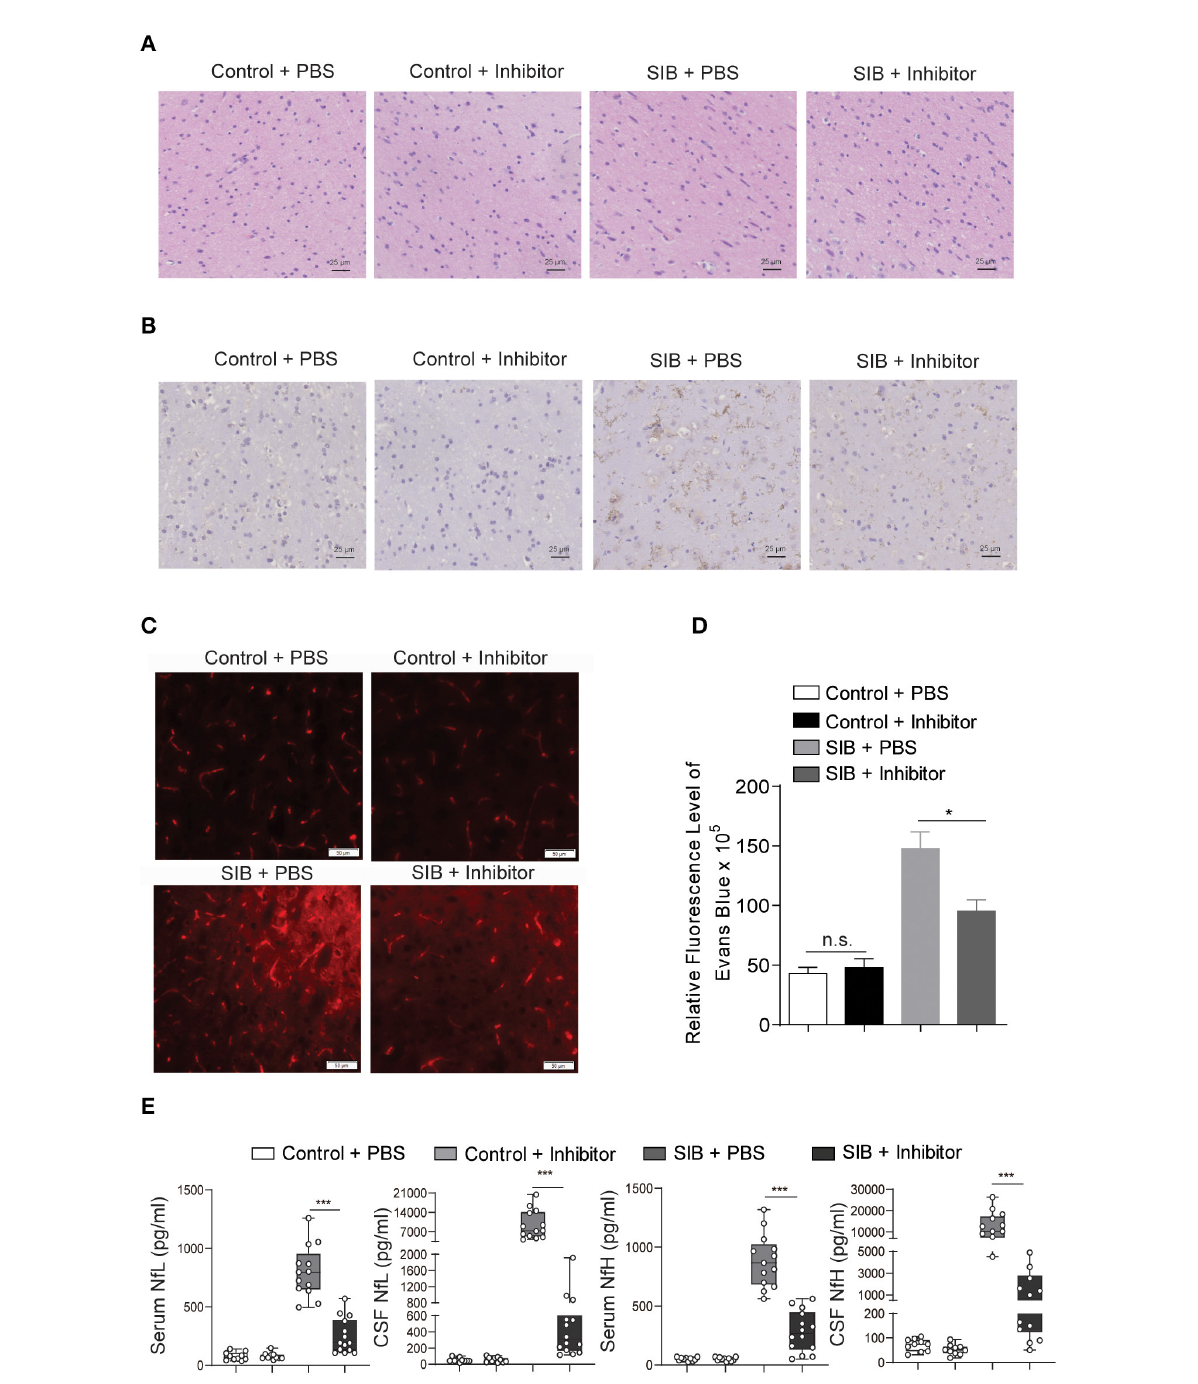
FIGURE5 CBP inhibitor markedly relieves the nerve damage in brain tissues. (A) The hyperplasia of microglial cells was relieved by inhibitor. Representative HE staining in the brain tissues. Scale bars, 25 µ m. Three micrographs per individual were performed for the photomicrographs. (B) Activated Iba-1 microglial cells were decreased in SIB + CBP30 group. Representative IHC stains of Iba-1 in the brain tissues. Scale bars, 25 µ m. Three micrographs per individual were performed for the photomicrographs. (C) Representative images of Evans Blue levels. Scale bars, 50 µ m. Three micrographs per individual were performed for the photomicrographs. (D) Quantifications of Evans Blue levels. (E) The levels of NfL and NfH in both four groups. Each symbol represents the serum and CSF cytokine levels (pg/ml) in one mink. Data shown represent the mean ± SEM; Control + PBS, n = 10; Control + inhibitor, n = 10; SIB + PBS, n = 13; SIB + inhibitor, n = 14. * p < 0.05, *** p < 0.001, n.s., no